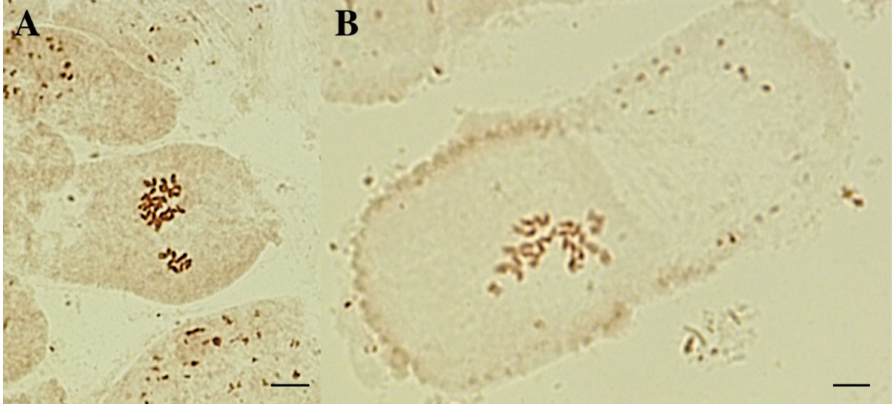
Figure 4. Metaphases in meristems of C. pepo regenerant plants with an aneuploid chromosome set: